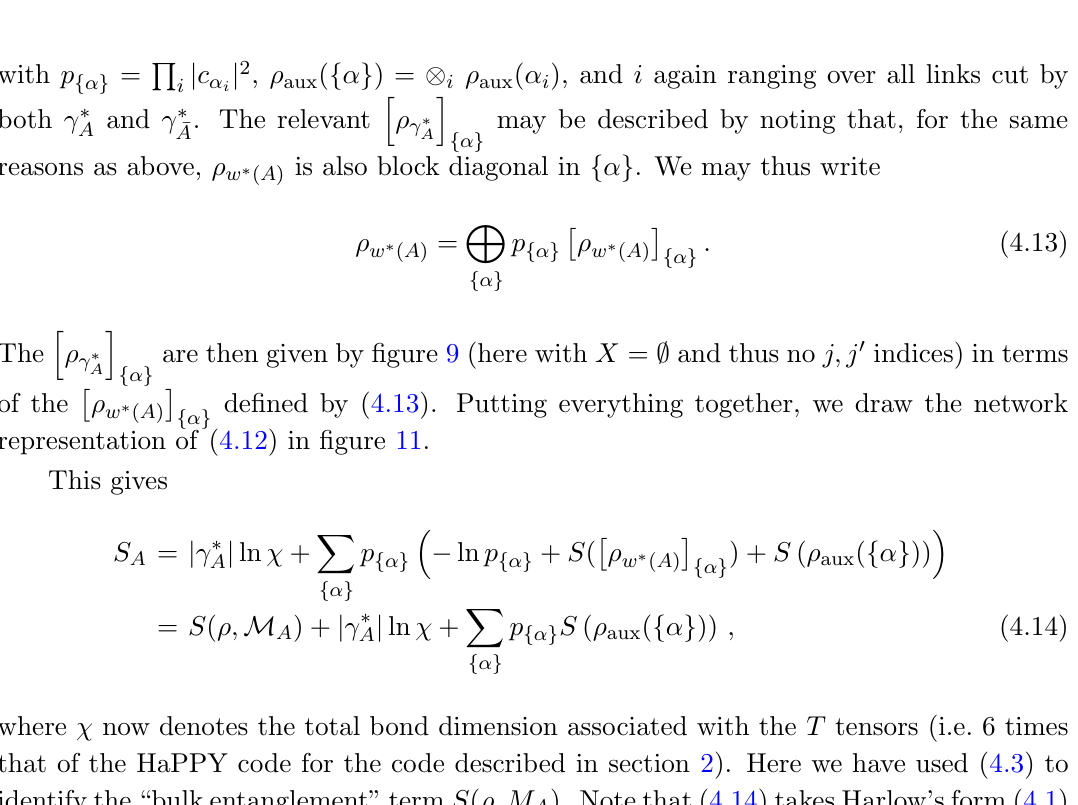
Figure 11. The state (cid:26) in (cid:12)gure 10 with respect to the (cid:11) basis. The index h ( (cid:11) i ) associated with the eigenvalue (cid:11) , and similarly for h ( (cid:11) i ) aux . Again we have drawn only one link i for